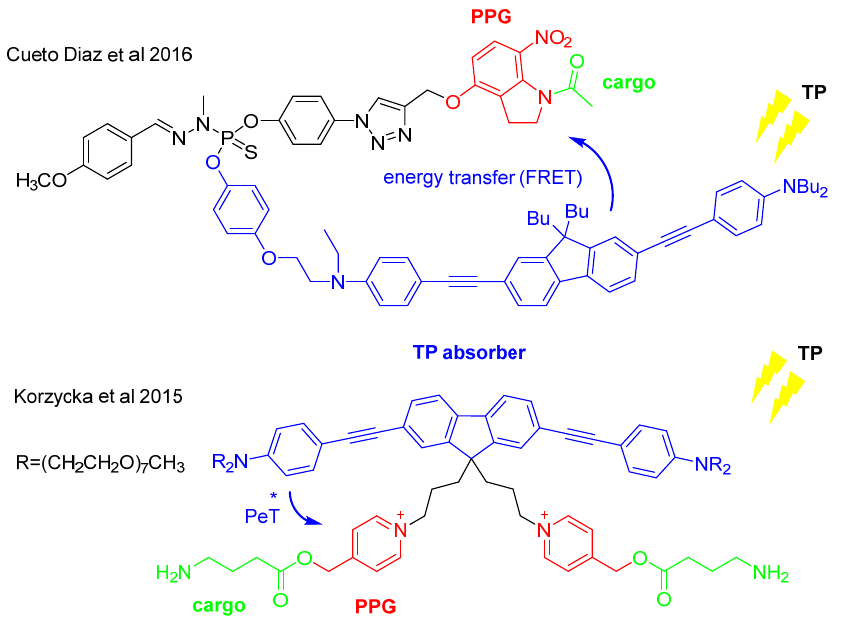
Figure 7. Antenna-sensitized tandem systems for TP uncaging based on photoinduced electron transfer (PET) or Förster resonance energy transfer (FRET) between the branches of the construct [8,55]. In the former case, upon TP excitation the TP-absorbing unit donates an electron to the pyridinium PPG unit (* referring to the photoexcited state), leading to a photochemical reaction and the release of the cargo [8]. The latter example is based on an appropriately selected FRET donor-acceptor pair (emission of the donor in sufficient overlap with the absorption of the acceptor) linked by a thiophosphoryl unit [55].